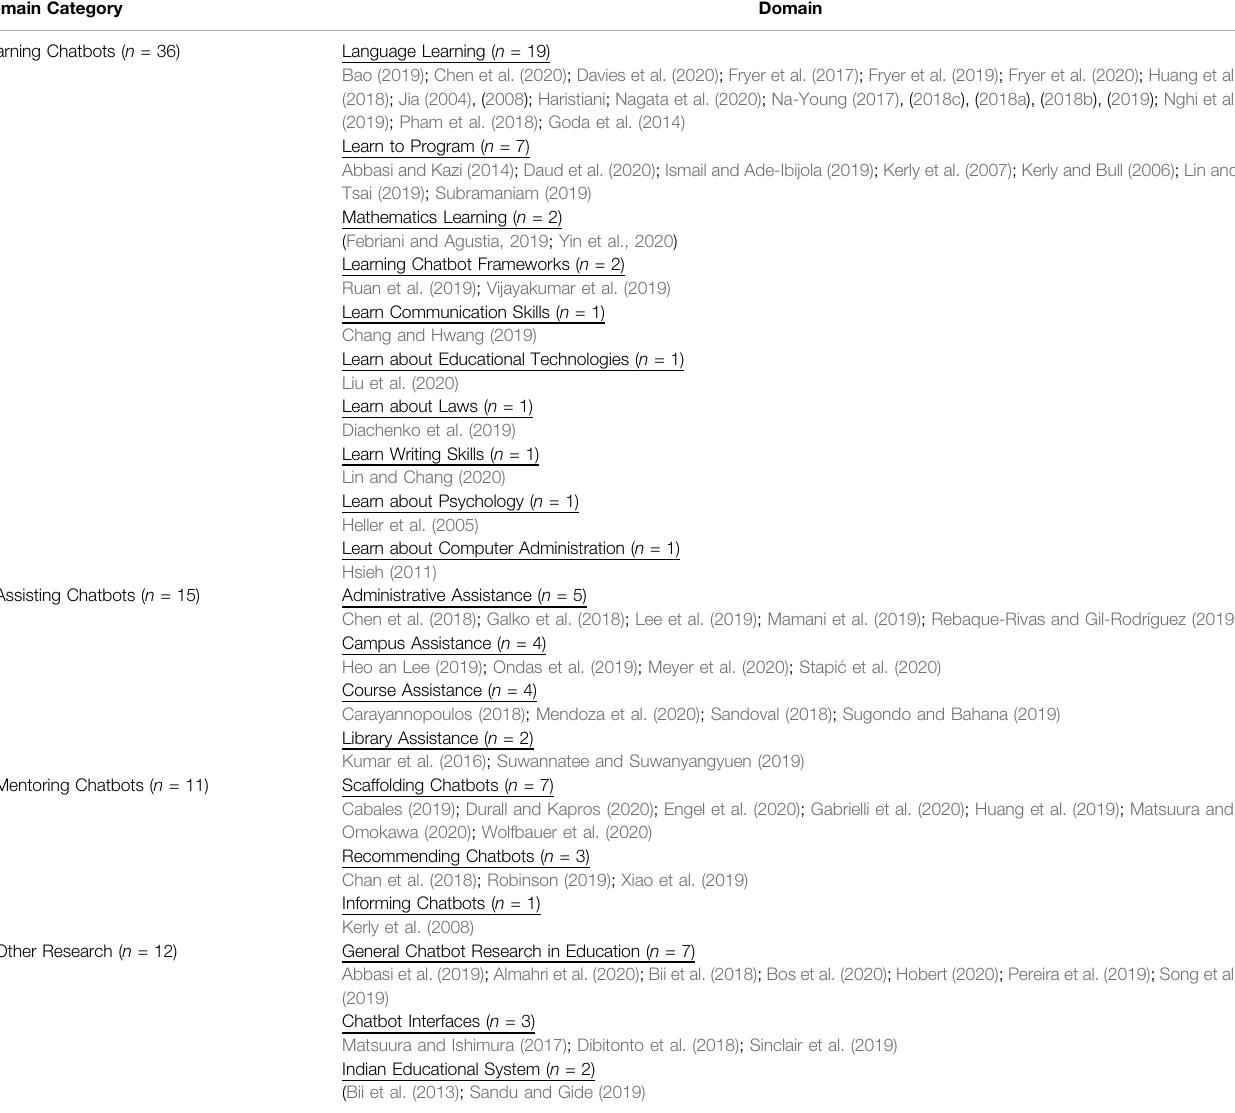
TABLE 3 | Domains of chatbots in